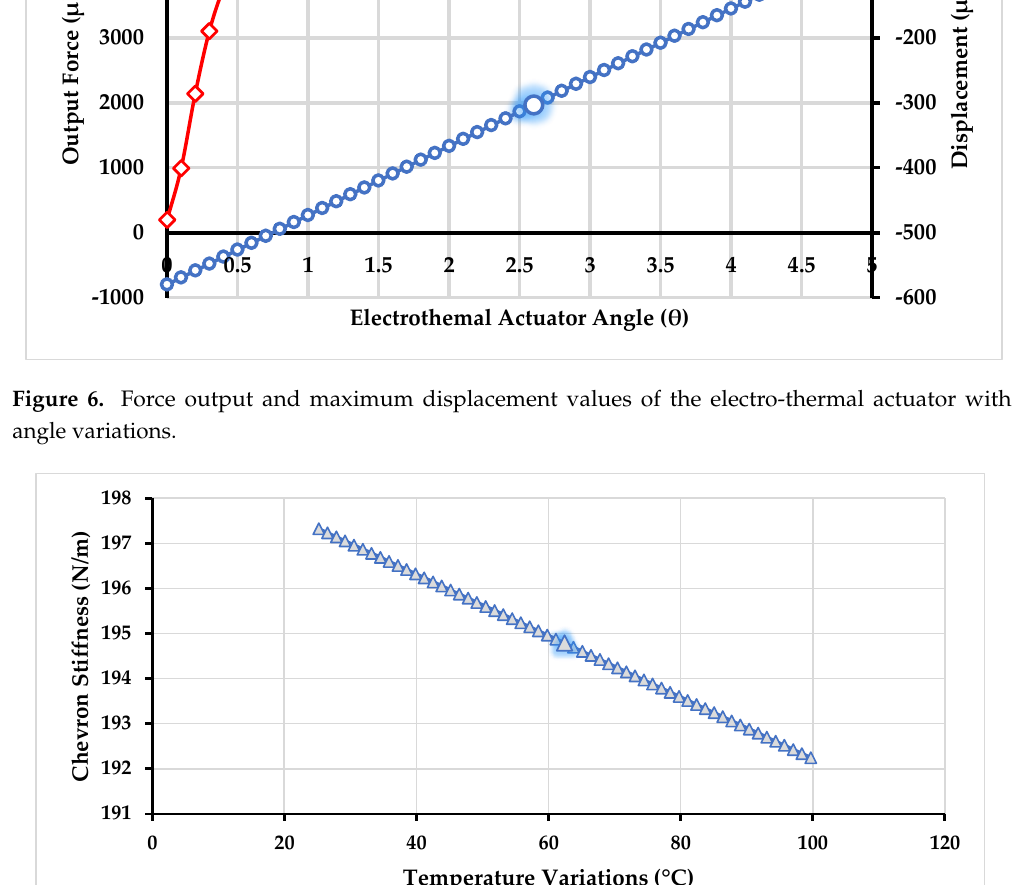
Figure 7. Stiffness values of the electro-thermal actuator with temperature variations.